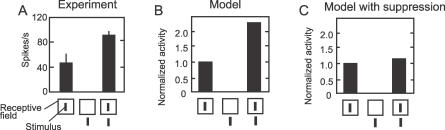
Contextual Modulation of Neuronal V1 Responses(A) Extracellular recordings from an orientation selective neuron in V1 of a monkey, activated by an optimal bar within its receptive field. The neuron does not respond if the bar is outside the receptive field. However, the neuronal response is strongly facilitated if the two collinear bars are presented together (left to right, Figure adapted from [18]).(B) The neuronal responses are reproduced by a network of two recurrently connected linear threshold units (see Equation 1 and Figure 2A).(C) The same model neuron in the presence of focal attention, modeled by top-down activation of recurrent inhibition (see text and Figure 2B1) is barely affected by the contextual bar (the parameters were chosen to reproduce the behavioral learning curves presented in the following, and the facilitation is therefore not fully suppressed). The suppression of the neuronal facilitation in the model is at least partially confirmed by in vivo recordings in monkeys during focal attention (see [18] and main text). Parameter values: g = 1, θ = 27 Hz, wij = 0.55, k = 0.45, w0 = 8.3, τD = 0.04s, θinh = 120 Hz.